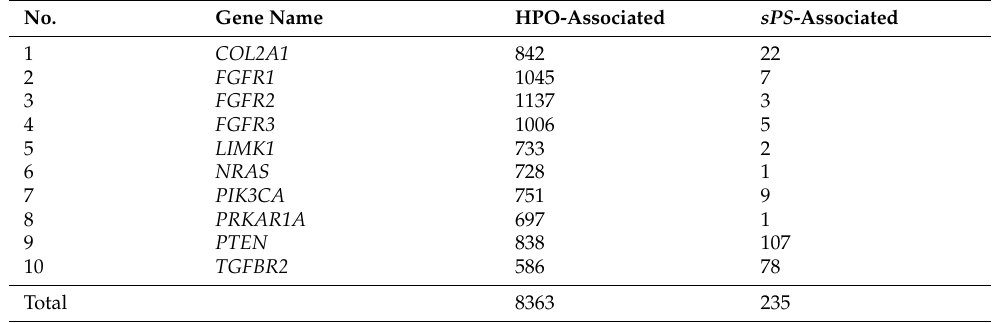
Table 1. The list of genes compared between the degree of pleiotropy by HPO and sPS . The top 10 genes with the highest degree of pleiotropy are chosen by the number of phenotypes in HPO database (‘HPO-associated’) and the number of KEGG genes affected by the knockout and the over-expression mutations in sPS (‘ sPS